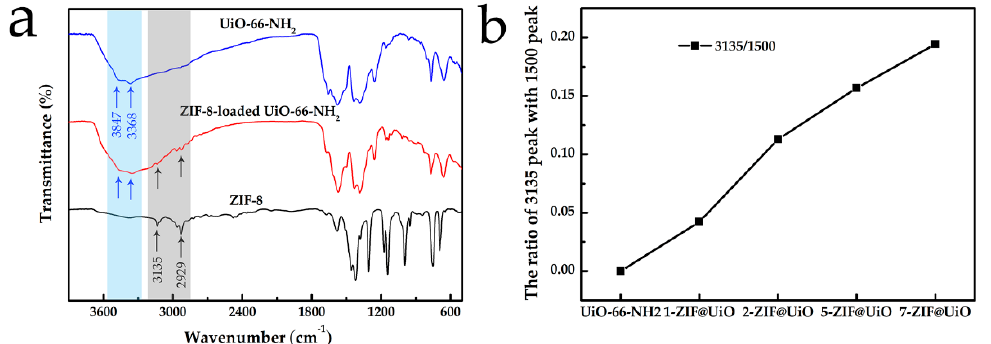
Figure 2. ( a ) Fourier transform infrared spectroscopy (FTIR) spectrum of zeolitic imidazolate framework-8 (ZIF-8)-loaded UiO-66-NH 2 , ZIF-8, and UiO-66-NH 2 . ( b ) semi-quantitative analysis of FTIR spectrum.